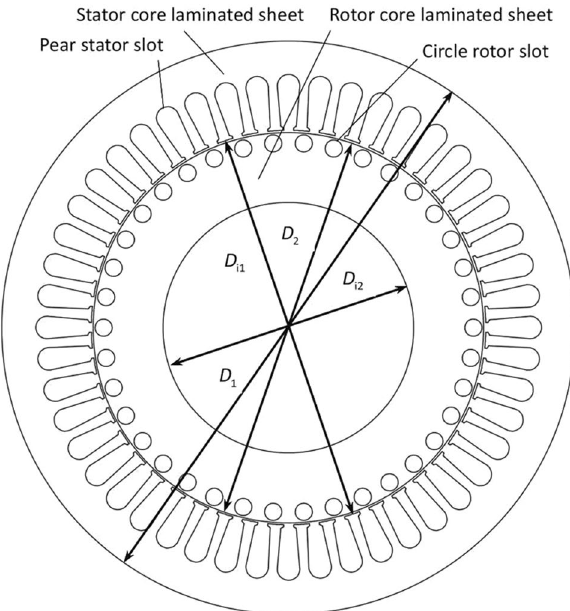
Figure 3. Laminated sheets of stator and rotor cores.